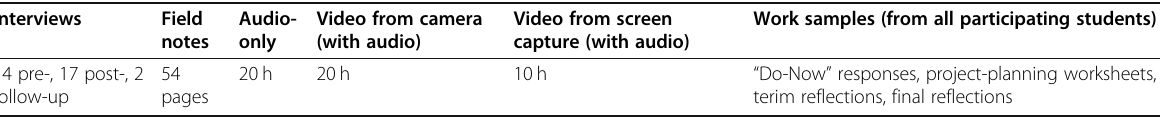
Table 3 Qualitative data sourcing during Phase 2